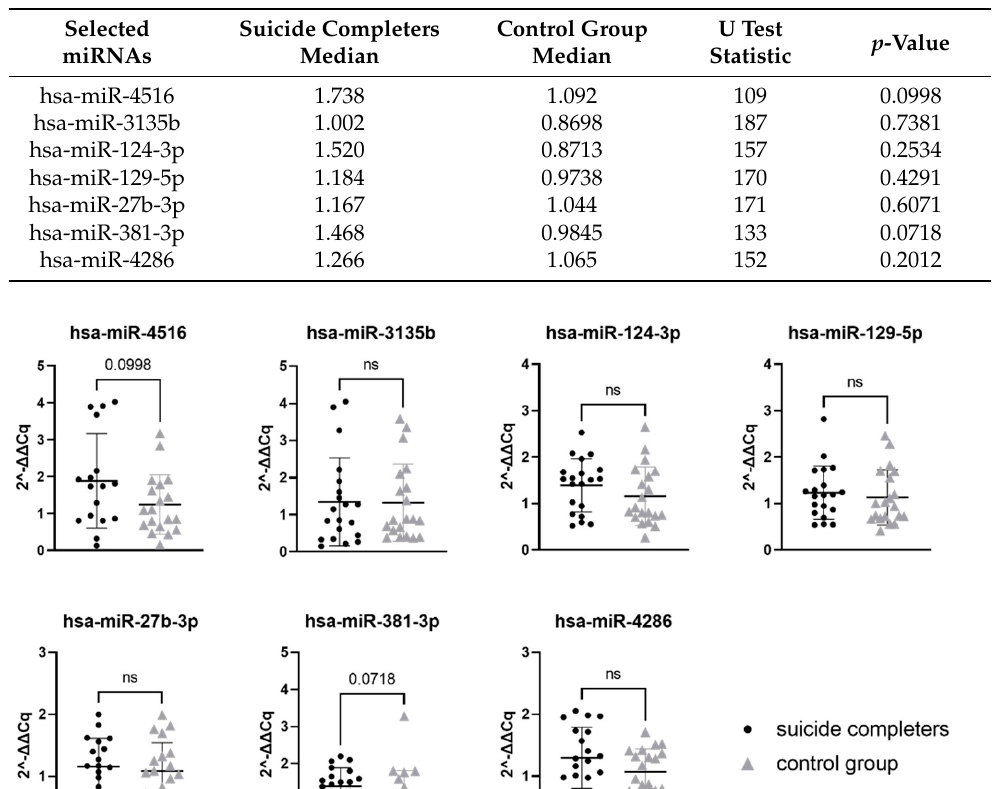
Table 4. Relative gene expression of miRNAs between suicide completers and control group subjects, determined using the Mann–Whitney U test.